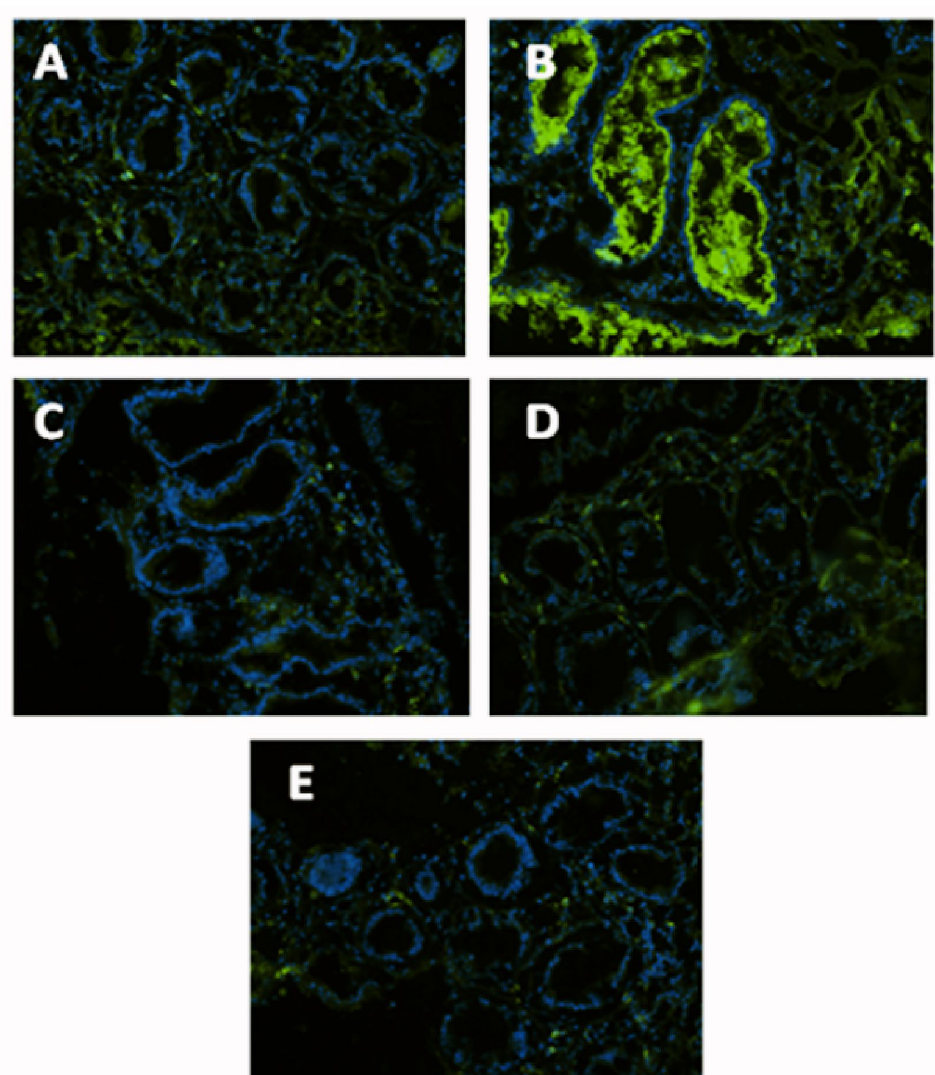
Figure 4. GAAE pre- treatment effect on p38 MAPK expression in situ in normal controls chal- Figure 4. GAAE pre-treatment effect on p38 MAPK expression in situ in normal controls chal- lenged with EC-LPS . ( A ) No treated biopsy; ( B ) Biopsy challenged with 1 µg/mL EC - LPS for 1 8 h; lenged with EC-LPS . ( A ) No treated biopsy; ( B ) Biopsy challenged with 1 µ g/mL EC-LPS for 18 h; ( C ) Biopsy pretreated 3 h with 50 µg/mL GAAE then challenged with 1 µg/mL EC - LPS for 1 8 h ; ( D ) ( C ) Biopsy pretreated 3 h with 50 µ g/mL GAAE then challenged with 1 µ g/mL EC-LPS for 18 h; ( D ) Biopsy Biopsy pretreated 3 h with 100 µg/mL GAAE then challenged with 1 µg/mL EC - LPS for 1 8 h ; ( E ) pretreated 3 h with 100 µ g/mL GAAE then challenged with 1 µ g/mL EC-LPS for 18 h; ( E ) Biopsy pretreated Biopsy pretreated only with 100 µg/mL GAAE for 21 h . only with 100 µ g/mL GAAE for 21